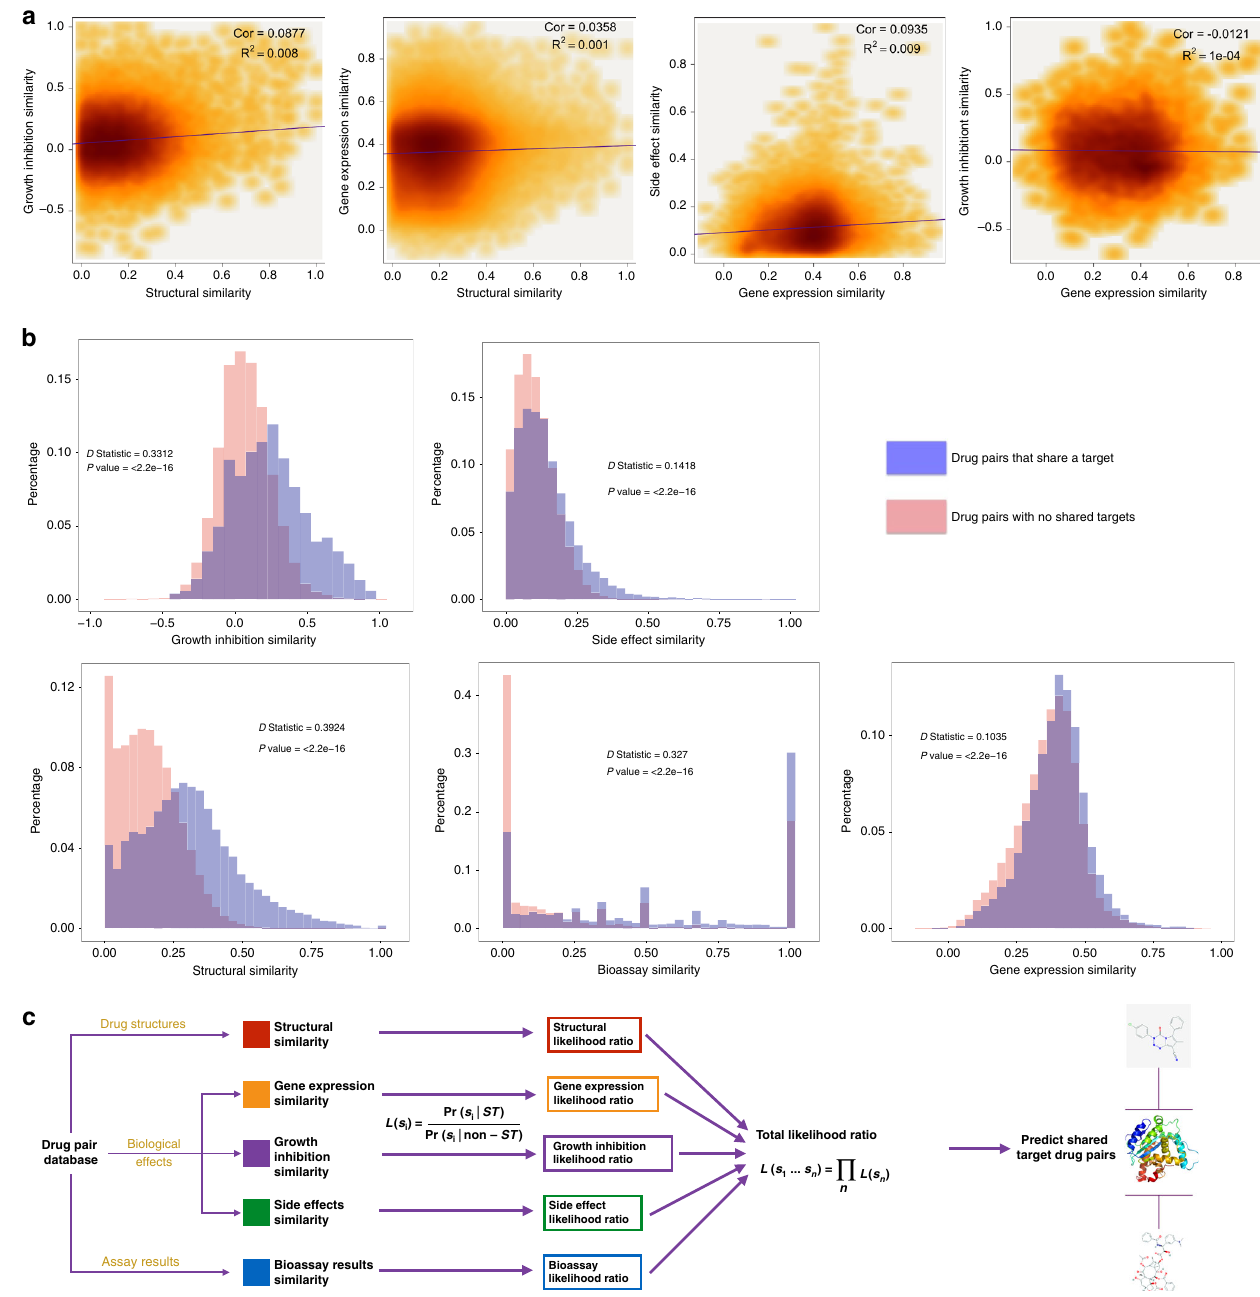
Fig. 1 BANDIT exploits the individual predictive powers of each data type. a Density plots showing how various different similarity scores correlate with one another, with darker area corresponding to a higher density of values. R 2 and P value were calculated using a pearson correlation. b Distributions of similarity scores across two sets — drug pairs known to share a target and those with no known shared targets. P values and D statistics were calculated using the Kolmogorov – Smirnov test. c Schematic of BANDIT ’ s method of integrating multiple data types to predict shared target drug